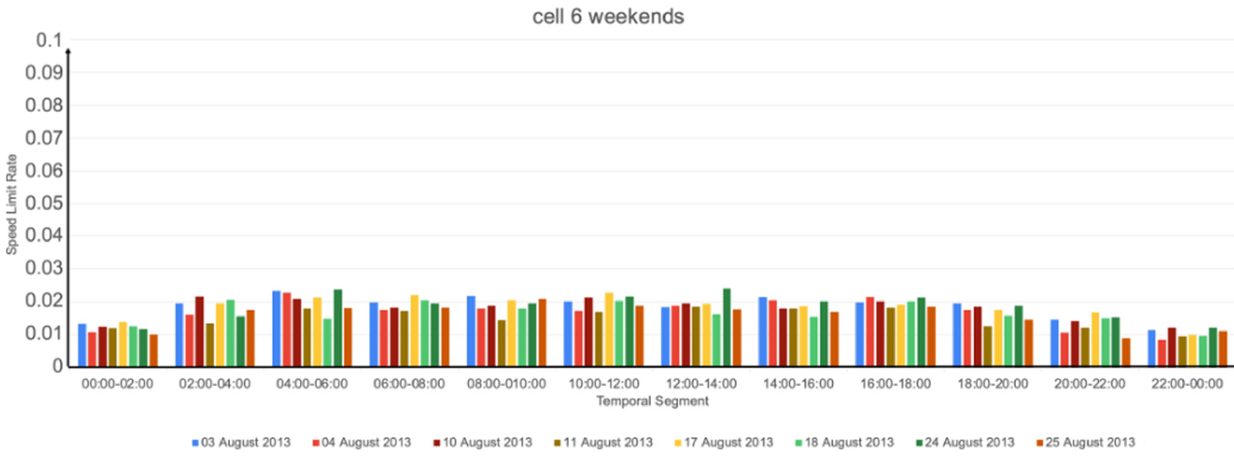
Figure A7. Results for the weekends, cell 6 with MaxSpeed = 10